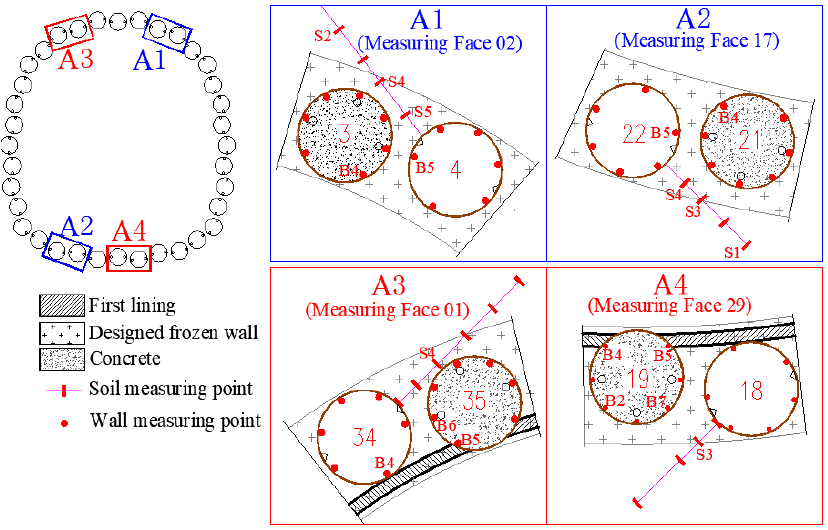
Figure 4. The analyzed areas and measuring points.